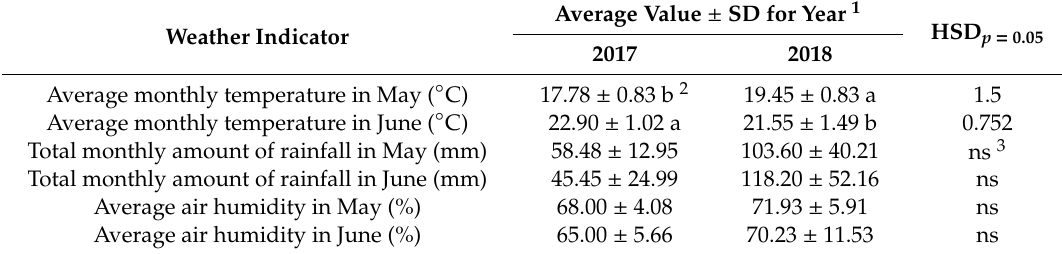
Table 1. Comparison of the weather conditions (the average monthly temperature in ◦ C, total amount of rainfall in mm, and average air humidity in %) in May and June between 2017 and 2018 and the result of statistical